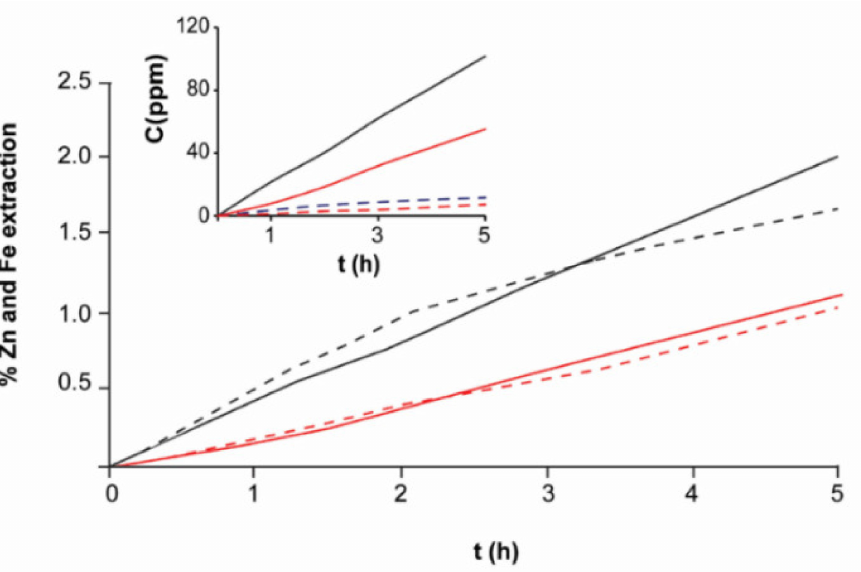
Figure 11. Percentage of extracted zinc and iron related to the initial sphalerite sample concentration (Zn, 5 g; Fe, 0.7 g) at 40 ◦ C. Red lines show the extraction at pH = 7; black lines, at pH = 2. Full lines represent Zn; dashed lines, Fe. The inserted plot indicates the concentration changes of zinc ions and ferrous